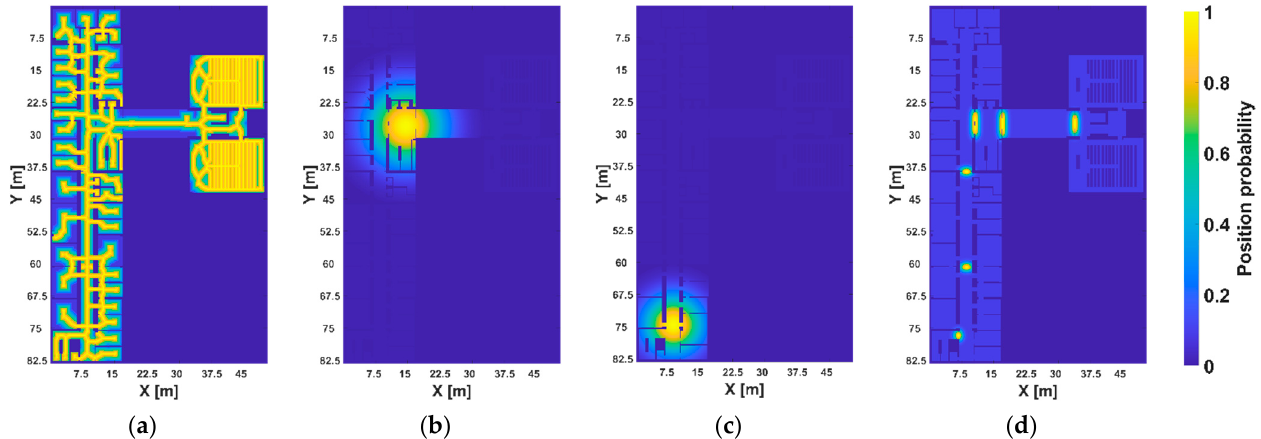
Figure 3. Measurement maps: ( a ) walkway structure of the indoor area; ( b ) Bluetooth Low Energy (BLE) fingerprinting based position estimation; ( c ) map of possible positions based on Wireless Local Area Network (WLAN) fingerprinting; ( d ) map of magnetic field anomalies.